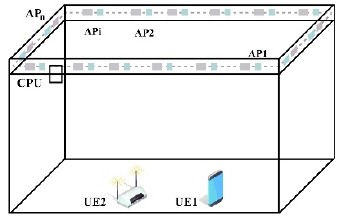
Figure 3. Block diagram of a typical scenario of radio stripe deployment [14].